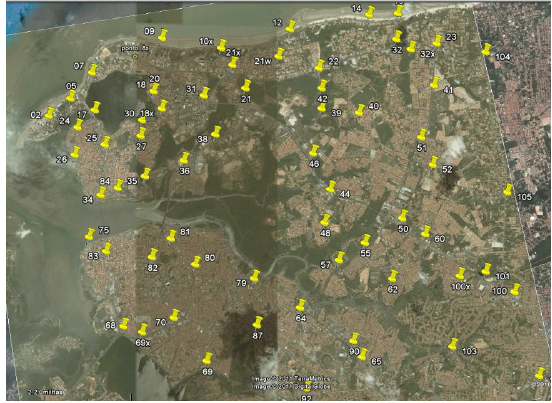
Figure 5: Distribution of GCPs in the area under study.